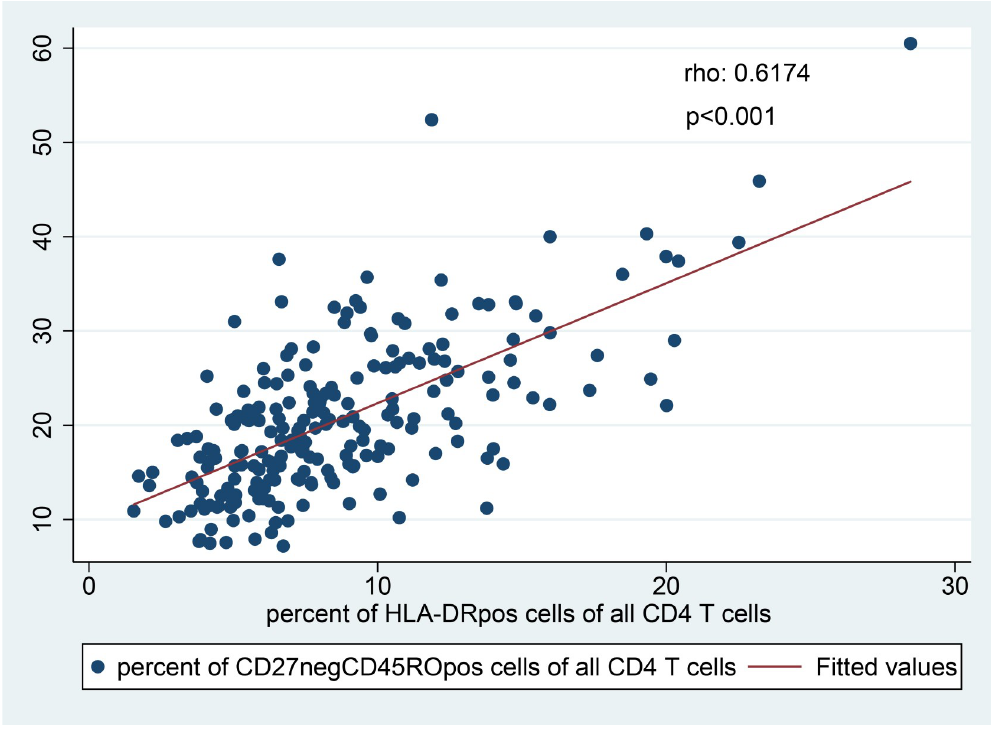
Fig 5. Correlation of effector memory cells (CD27 neg CD45RO pos CD4 T cells) and activation status (HLADR pos CD4 T cells). A positive correlation was found (Spearman’s rho = 0.617, p < 0.001).